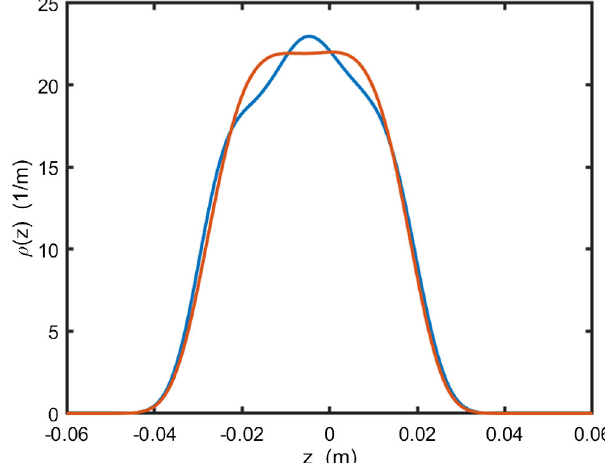
FIG. 15. Fit of Re Z to Lorentzian and LRC circuit formulas.